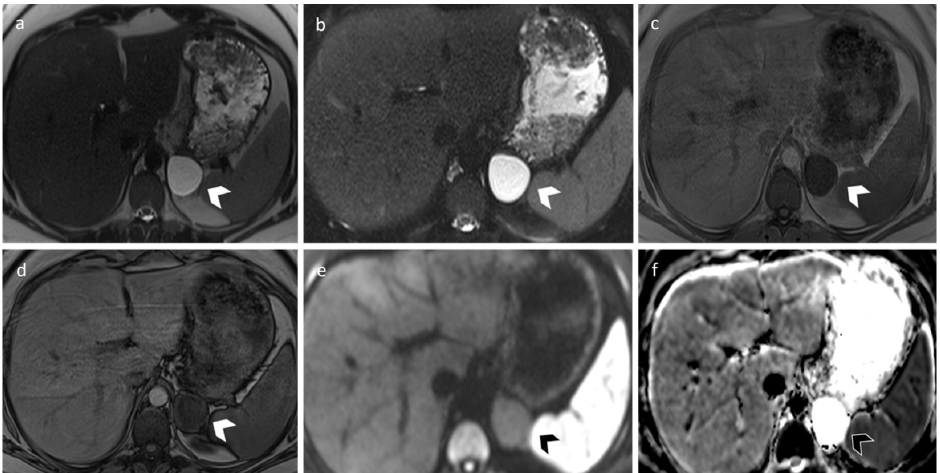
Figure 4. A 33-year-old female with an incidental left adrenal cyst. MR revealed a 4 cm nodular lesion in the left adrenal gland characterized by thin walls and high and homogeneous signal in T2 ( a ) and T2 fat-sat sequences ( b ). T1 signal ( c , d ) is in accordance with simple fluid content, and DWI/ADC sequence ( e , f ) does not show signs of hypercellularity.